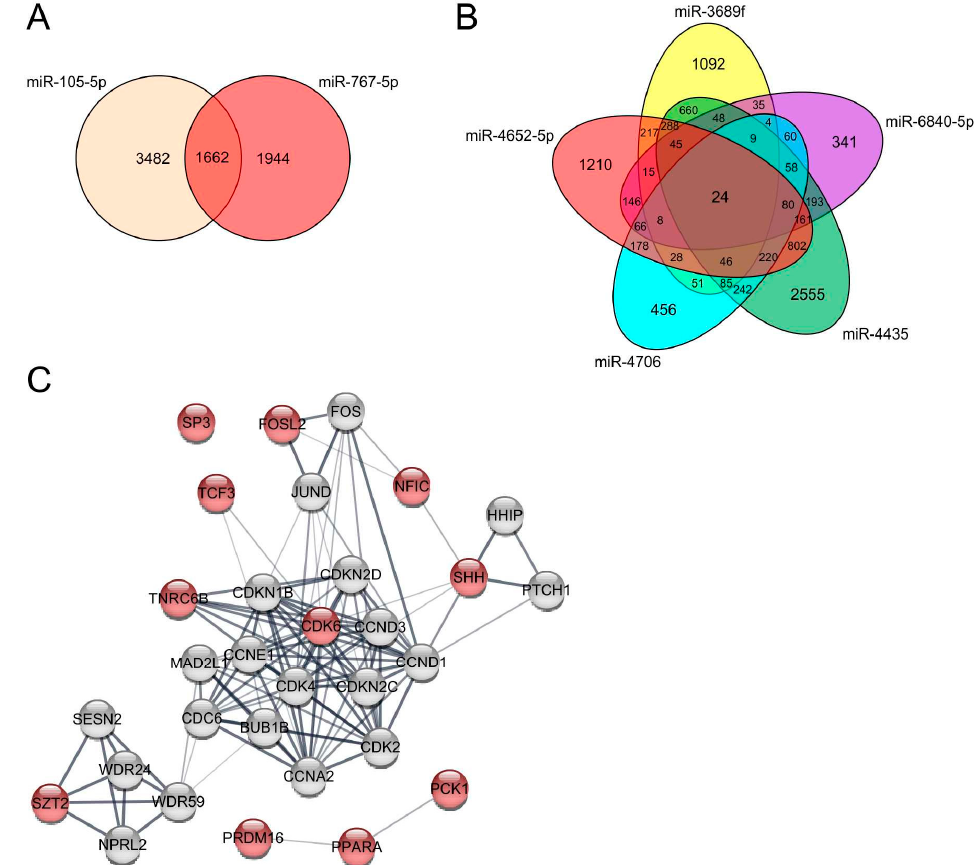
Figure 3. Target gene analysis of strongly upregulated miRNAs in melanoma compared to MBrCs and NHEMs. ( A ) Venn diagram of predicted targets of miR-105-5p and miR-767-5p. ( B ) Venn diagram of predicted target genes of miR-3689f, miR-6840-5p, miR-4652-5p, miR-4706, and miR-4435. ( C ) STRING network analysis of selected target genes of the 24 shared target genes of miR-3689f, miR-6840-5p, miR-4652-5p, miR-4706, and miR-4435 (red), and additional genes involved in the network (grey).